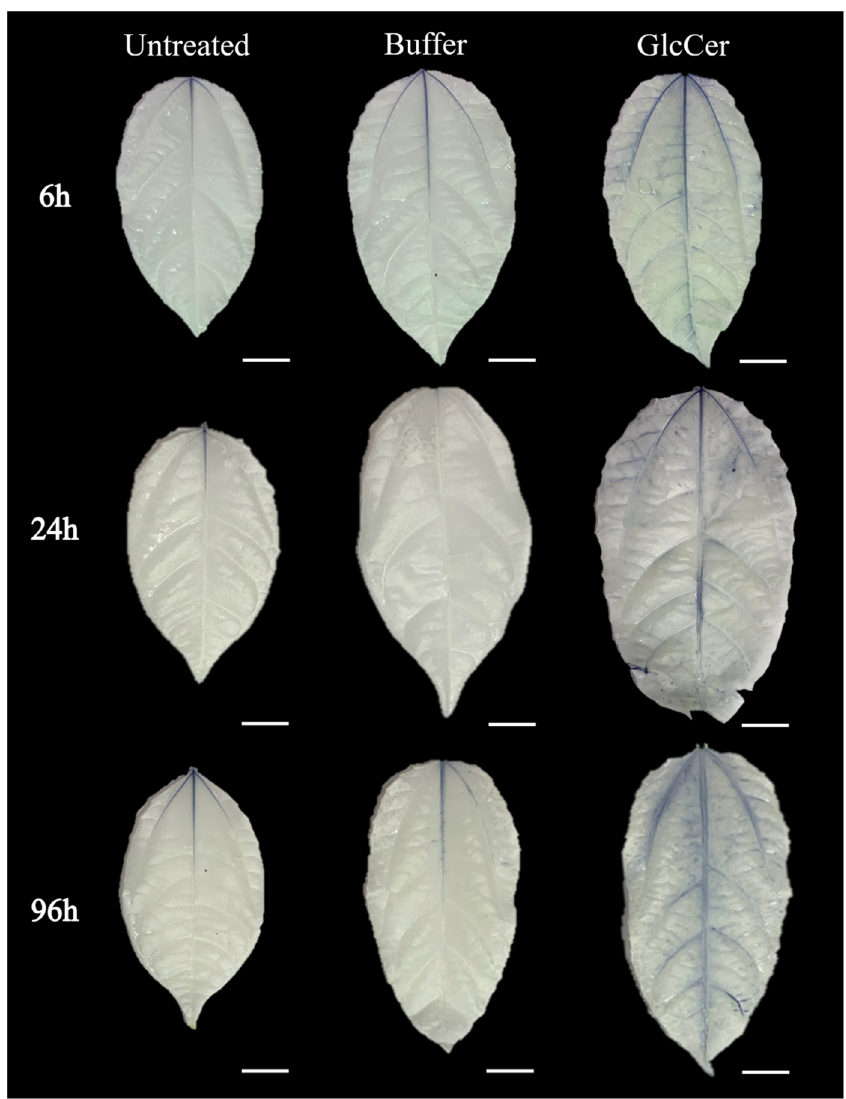
Figure 6. Histochemical visualization of reactive oxygen species (ROS) accumulation in leaves of P. edulis collected at 6, 24 and 96 h after treatment with C. herbarum GlcCer. The accumulation of O₂⁻ is evidenced by the violet color (NBT precipitation). Bar: 2 cm. is evidenced by the violet color (NBT precipitation). Bar: 2